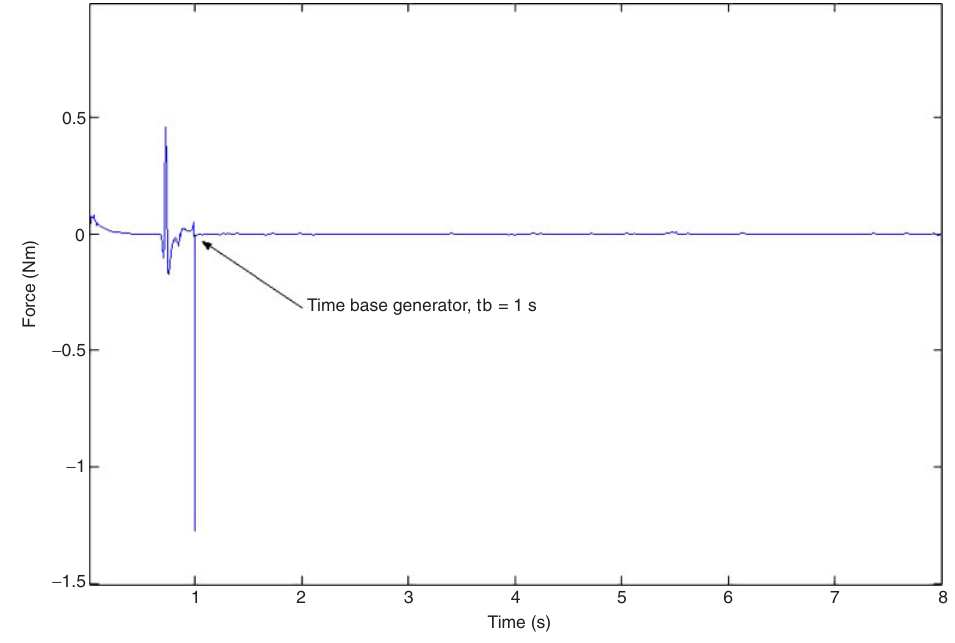
Figure 8 Contact force error (tracking in t b = 1 s).